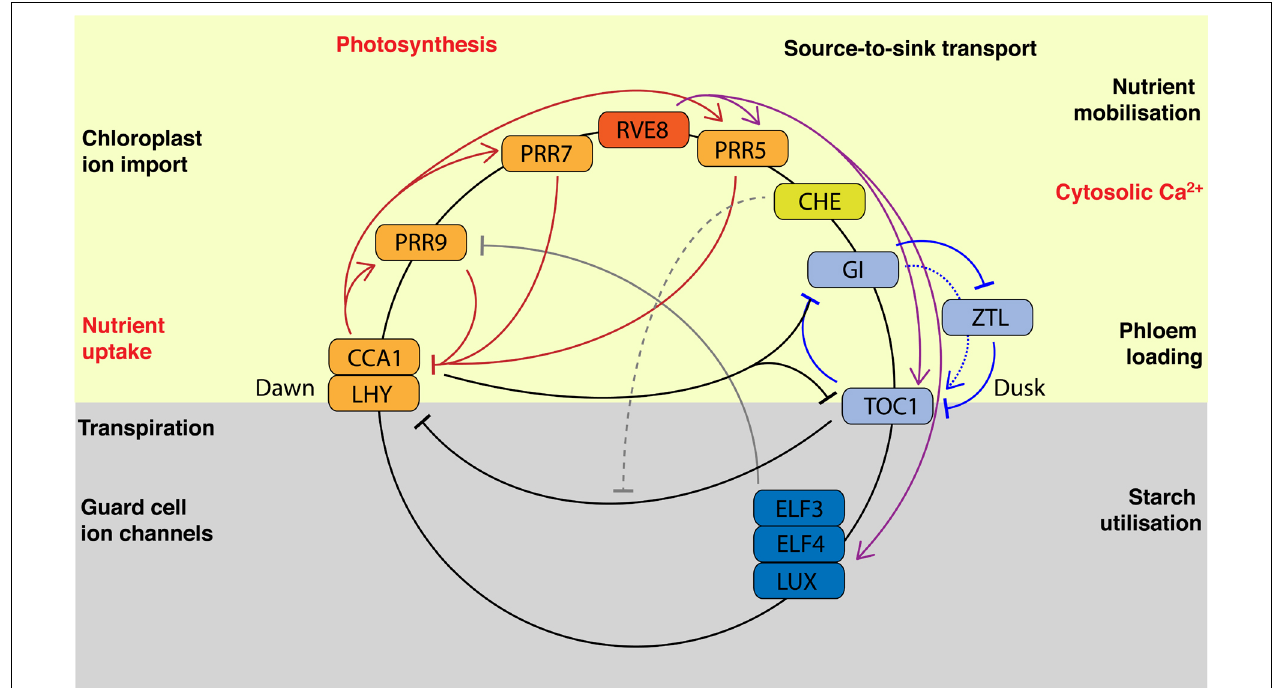
FIGURE 1 | Circadian regulated nutrient homeostasis. The current model of the Arabidopsis circadian clock is comprised of multiple interlocking regulatory feedback loops and is described in detail elsewhere (Hsu and Harmer, 2014). Briefly, morning-expressed CIRCADIAN CLOCK ASSOCIATED1 (CCA1) and LATE ELONGATED HYPOCOTYL (LHY) and afternoon expressed REVEILLE8 (RVE8) encode related Myb-like transcription factors that activate transcriptional repressors in a time-of-day dependent manner. Thus, the transcriptional repressors PSEUDO-RESPONSE REGULATOR9 (PRR9) , PRR7, PRR5, and PRR1/TIMING OF CAB1 (TOC1) are expressed sequentially to act on CCA1 and LHY . CCA1 HIKING EXPEDITION (CHE) inhibits repression of CCA1